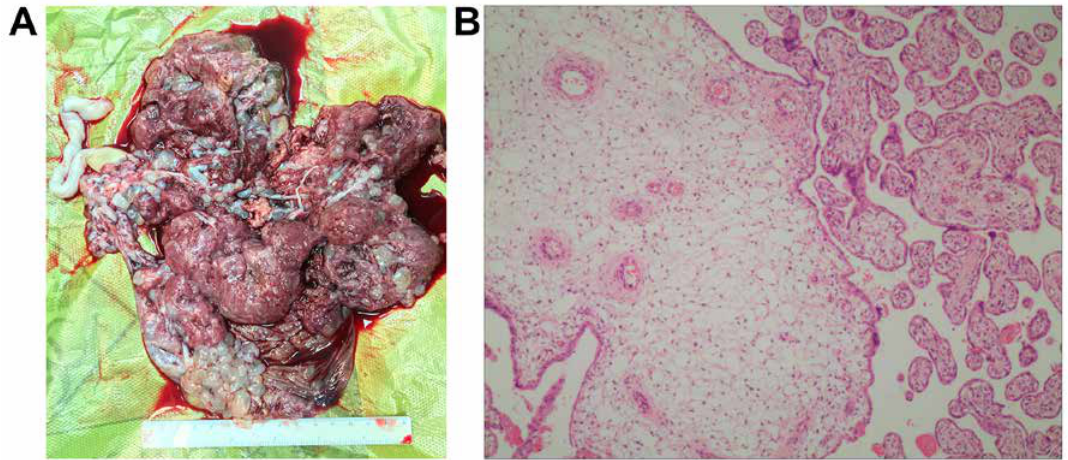
Figure 1: (A) The placenta was large and hydropic, with necrotic debris; (B) The trophoblastic hyperplasia of villous surfaces was limited and focally reminiscent of partial hydatidiform mole (Magnification was ×